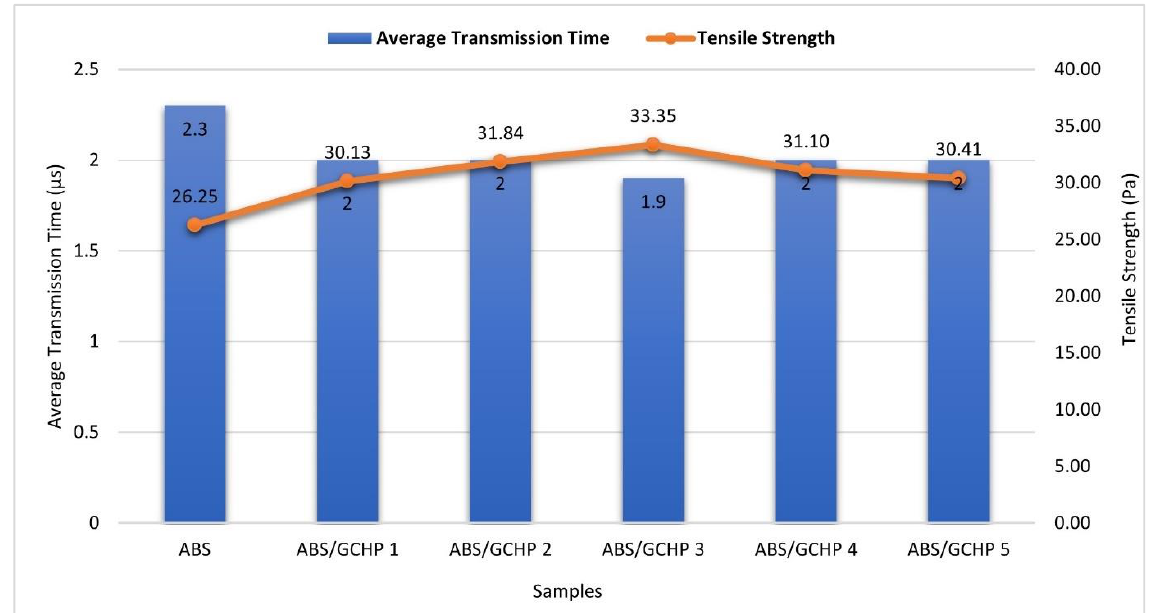
Figure 10. Correlation between average transmission times and tensile strength for ABS/GCHP composites.